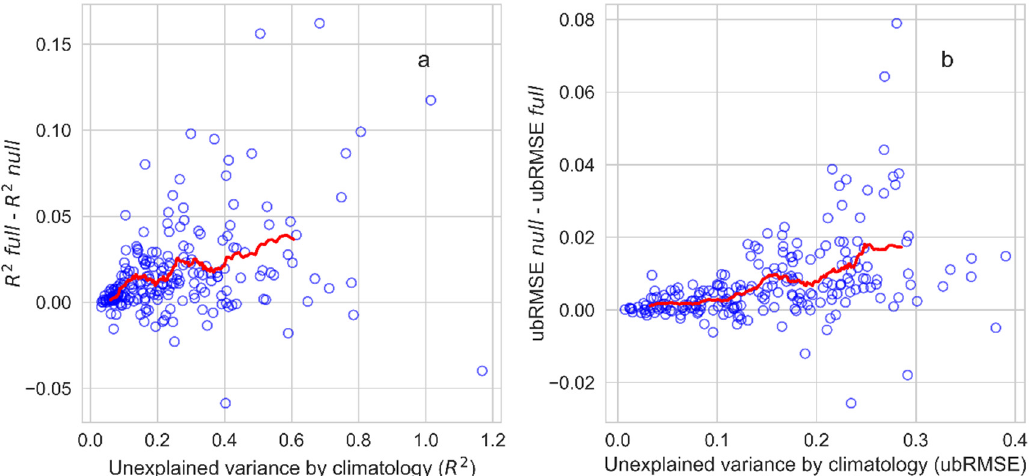
Figure 9. The difference in R 2 s between “ full ” model and “ null ” model reconstructed LAI predictions as a function unexplained variance by LAI climatology (1-R 2 between LAI and its climatology) ( a ), and the reduction in ubRMSE from “ null ” model to “ full ” model as a function of unexplained variance by LAI climatology (ubRMSE of LAI climatology). The red lines in ( a , b ) are the moving average using a window length of 15% of the data.